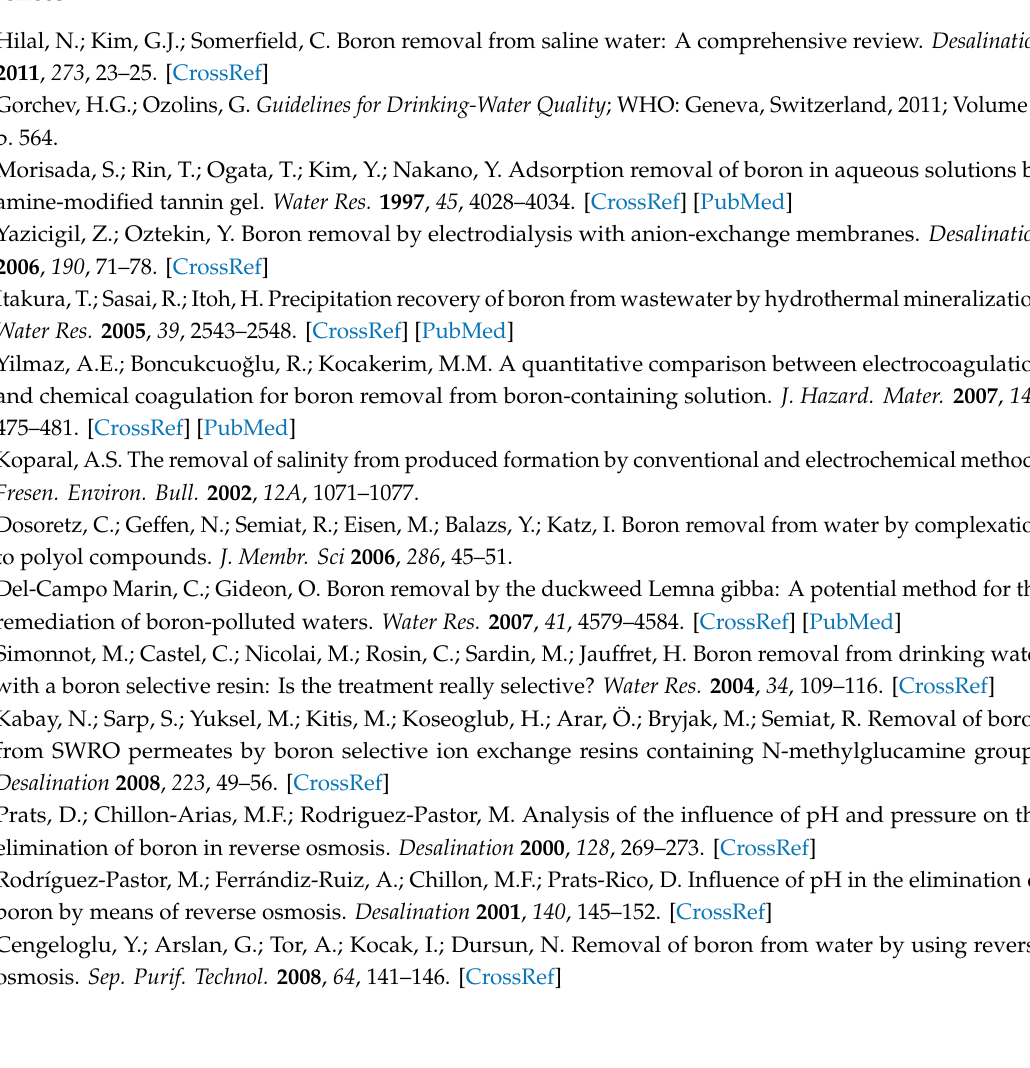
Figure S1. Scheme of the manufacturing process of CA and CAAl sorbents. Figure S2. Thermogravimetric analyses. S2a. TGA curve of CA. S2b TGA curve of CAAl. Figure S3. Species of boron and aluminum as a function of pH. Figure S4. Boron sorption isotherms using three di ff erent alginates and commercial resin AMBERLITE-IRA 743 (pH 9.5, V = 100 mL, T room, 1 atm). Figure S5. Intraparticle di ff usion plot for boron removal. Figure S6. SEM Images of the air-dried sorbents. S6a. Calcium alginate (CA) beads. S6b Composite alginate-alumina (CAAl) beads. Table S1. Main features of AMBERLITE